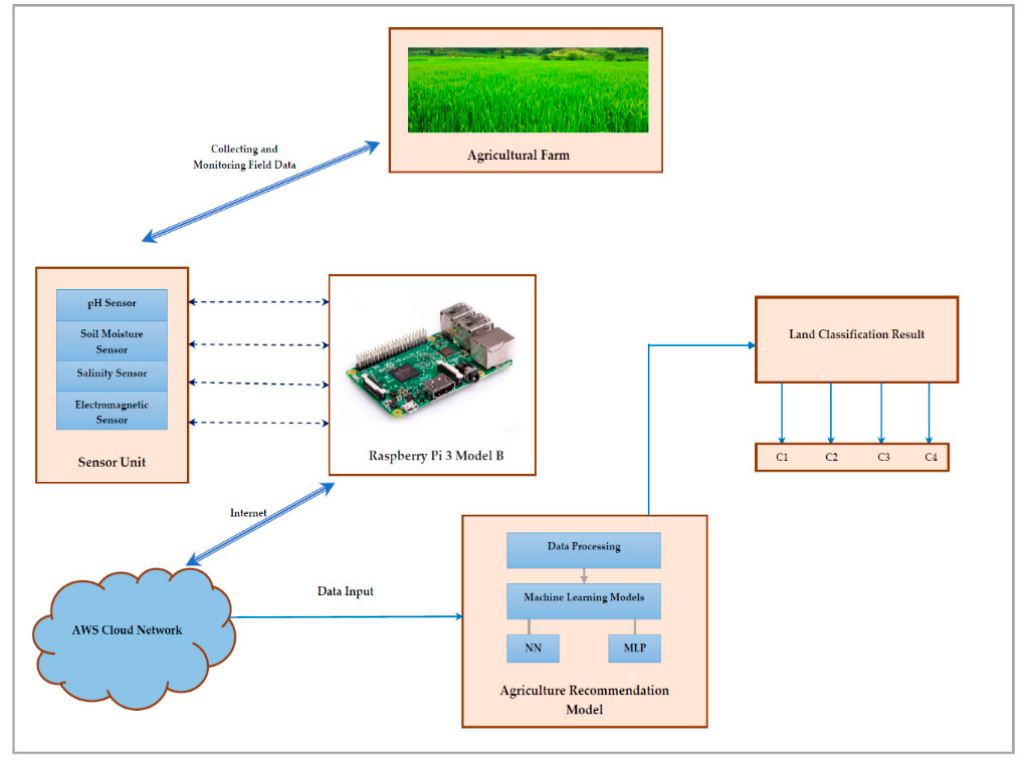
Figure 1. Architecture diagram of the proposed model.